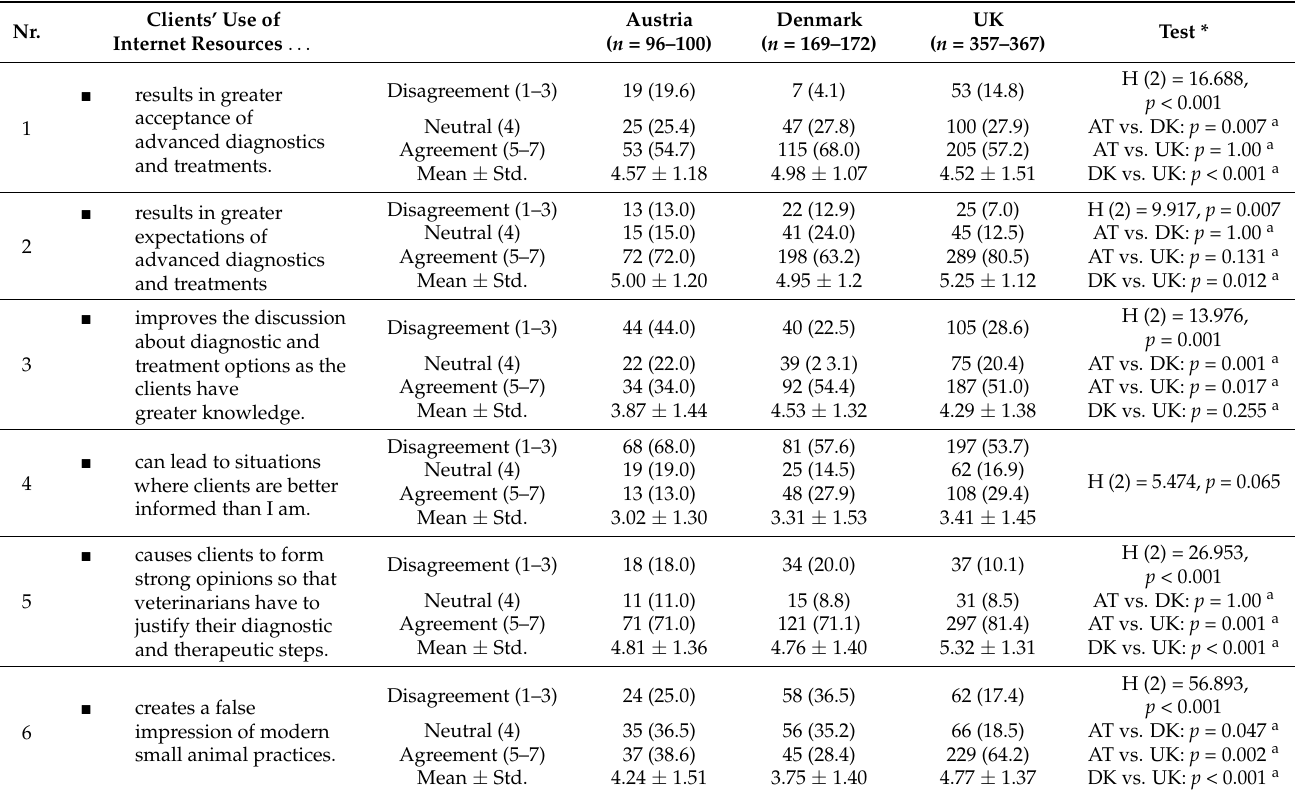
Table 2. Veterinarians’ attitudes towards clients’ use of internet